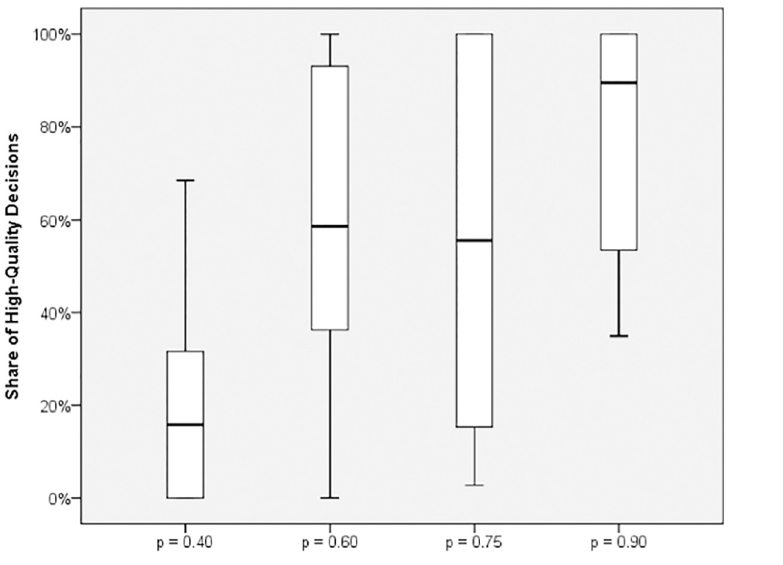
Fig 4. High-quality rate plotted for the four treatments.